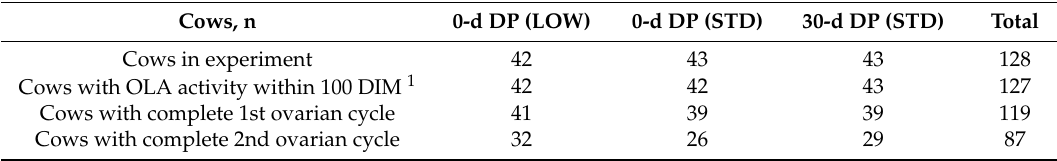
Figure 1. Overview of experimental design and sampling protocol for cows with di ff erent transition treatments. 30-d DP = 30 days dry period; 0-d DP = 0 day dry period; STD = standard energy level; LOW = low energy level. Table 1. Distribution of cows with 0 (0-d DP) or 30 days (30-d DP) of dry period and fed a low (LOW) or standard (STD) dietary energy